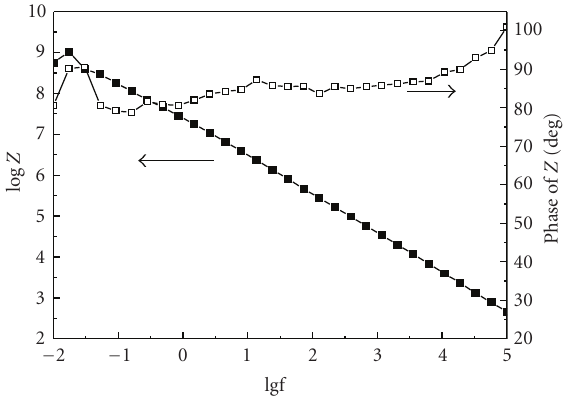
Figure 2: EIS Bode graph before accelerated degradation test of coated samples.